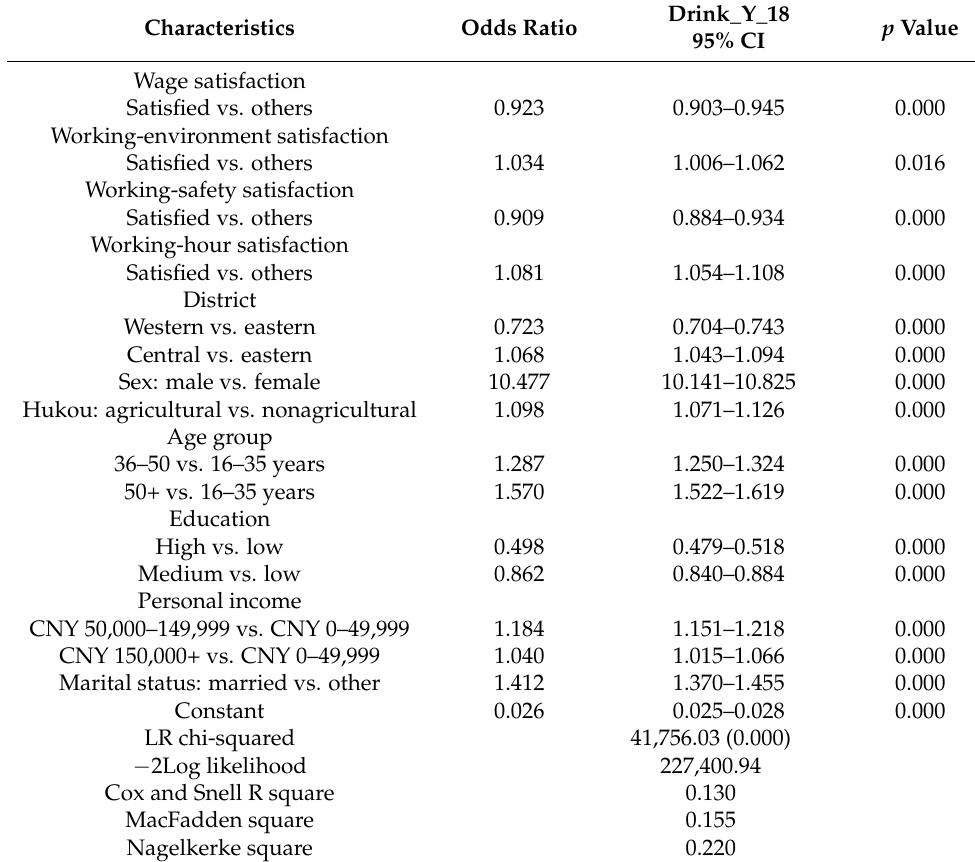
Table 3. Multivariable logistic regression